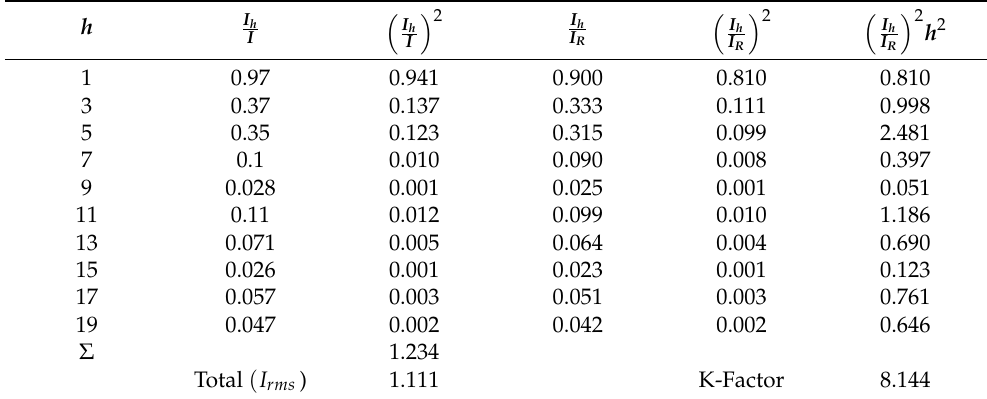
Table 13. Computation of the K-Factor.